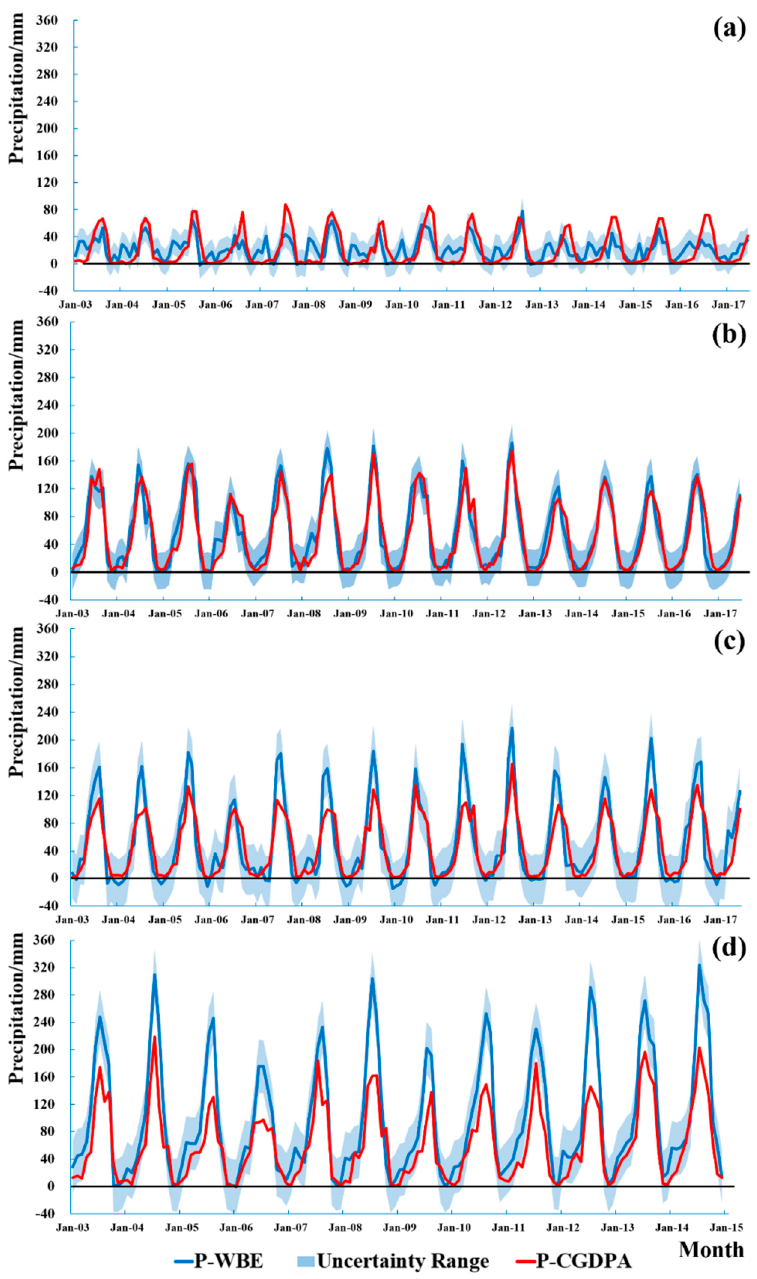
Figure 3. Precipitation estimated from WBE and CGDPA: ( a ) QT, ( b ) UYA, ( c ) UYE, and ( d ) YZ. The shades indicate the monthly precipitation uncertainty range calculated from the WBE method. The time series begins in January 2003, and there are 174 months in total for QT, UYA, and UYE, 144 months for YZ.